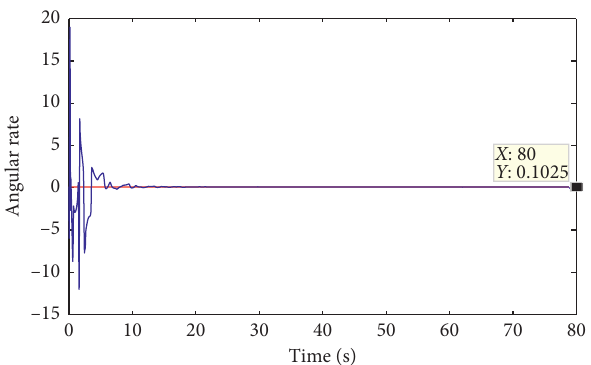
Figure 16: Adaptation of angular velocity using fractional fast TSMC.